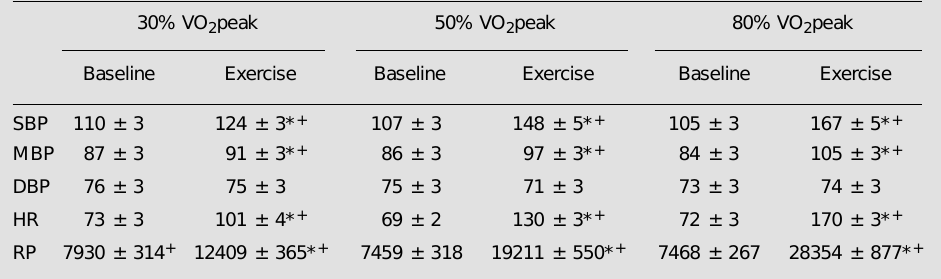
Table 2 - Systolic (SBP), mean (MBP) and diastolic (DBP) blood pressures, heart rate (HR), and rate pressure product (RP) measured at baseline and during exercise at 30, 50 and 80% of VO 2 peak. *P<0.05 significantly different from baseline. + P<0.05 significantly different from other intensities (two-way analysis of variance for repeated measures and Scheffé ’ s post-hoc